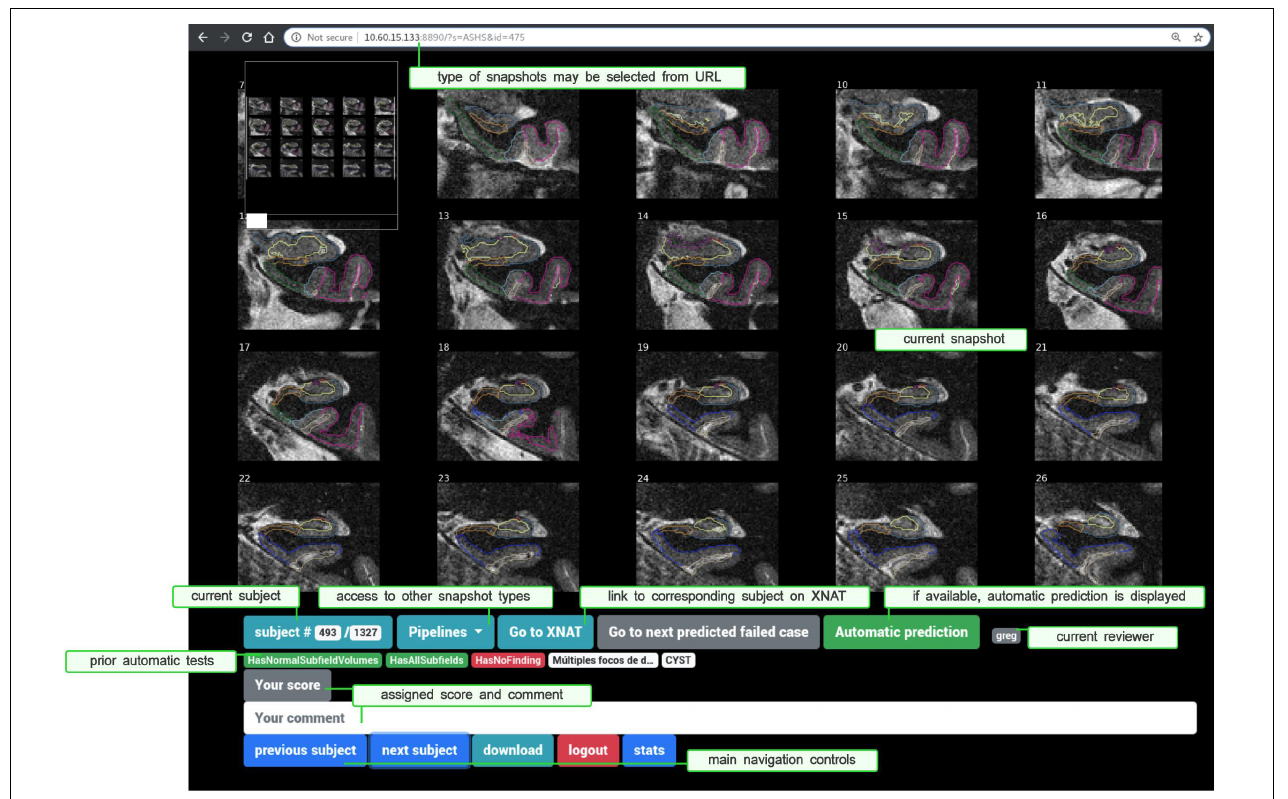
FIGURE 4 | Snaprate: General user interface, running in a web browser. The upper part displays a zoomable snapshot (here a segmentation of hippocampal subfields). The lower part shows a section for the review section and navigation controls, including links to XNAT and to other types of snapshots. Results from prior checkpoints are also displayed in red (if failed) or green (if